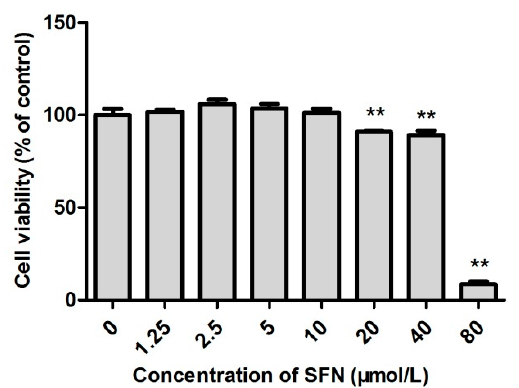
Figure 2. Effect of sulforaphane on the survival rate of TM3 cells. * and ** represent a significant and an extremely significant difference, respectively, compared with the control group.